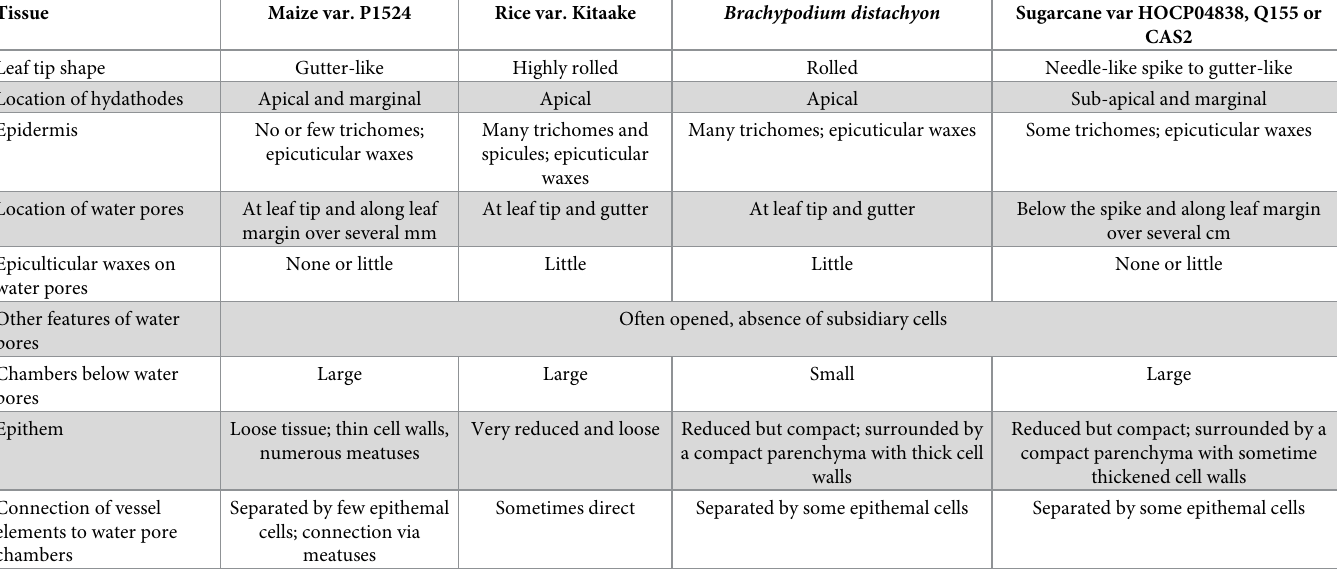
Table 1. Main characteristics of tissues from leaf apical hydathodes of maize, rice, Brachypodium distachyon and sugarcane.